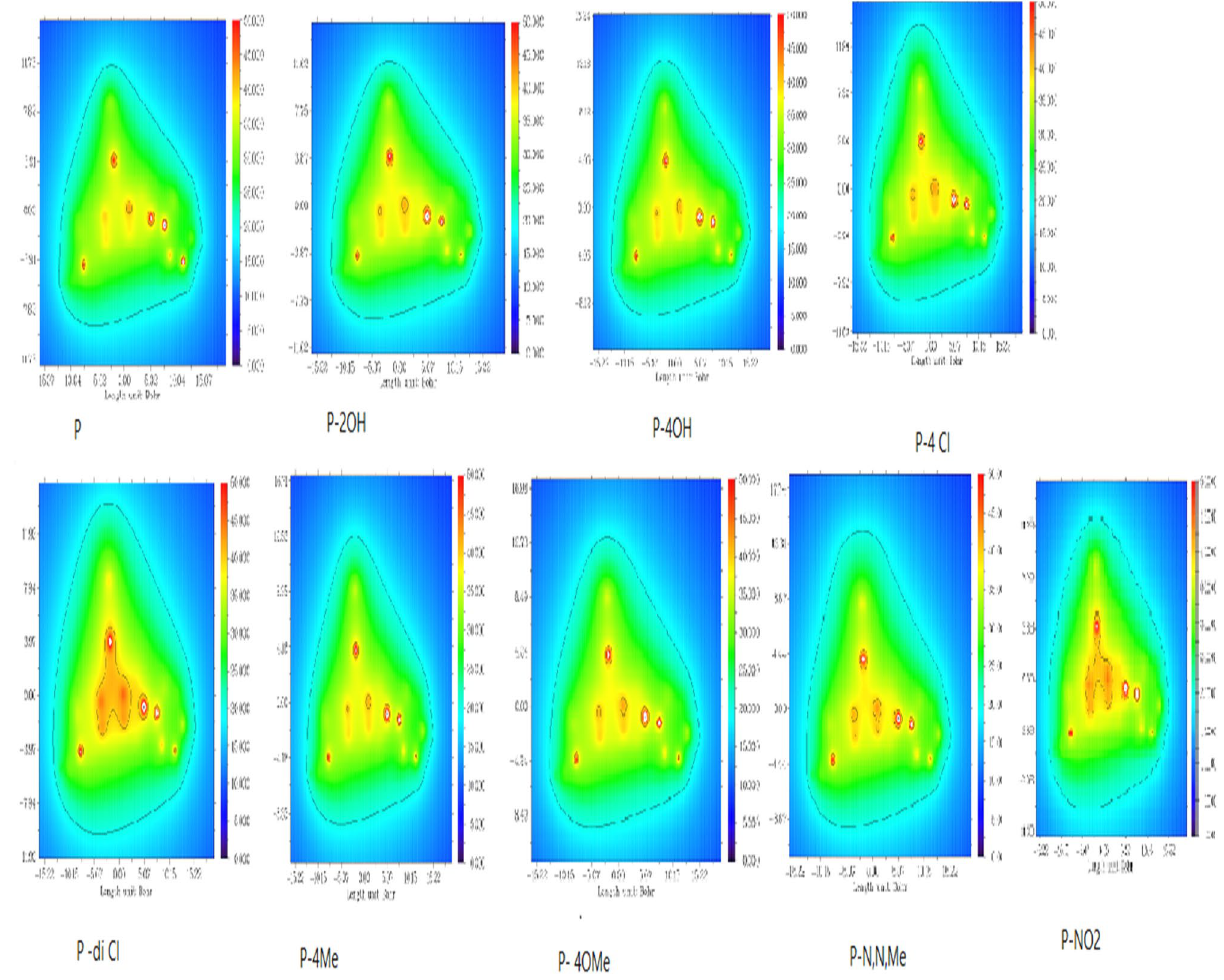
Figure 5. Electrostatic potential from nuclear charges of pyrazoloquinolines derivatives contours (https:// www. wavef un.